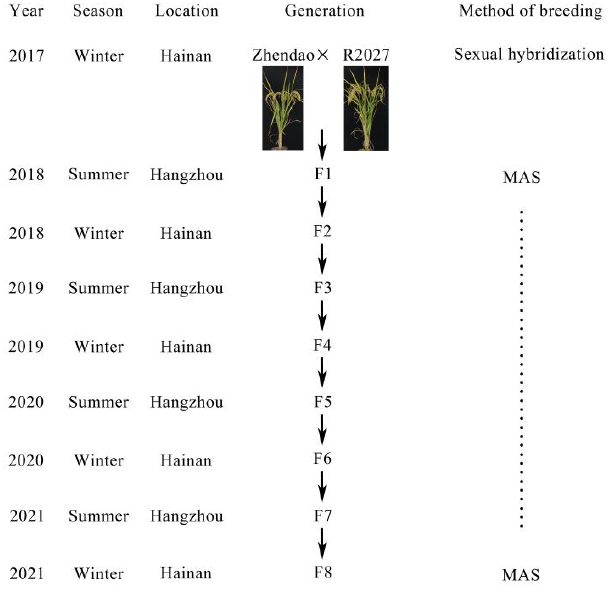
Figure 3. Breeding the hybrid progeny of Zhendao and R2027.